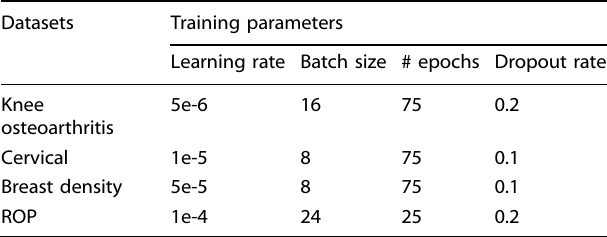
Table 2. Overview of training parameters by